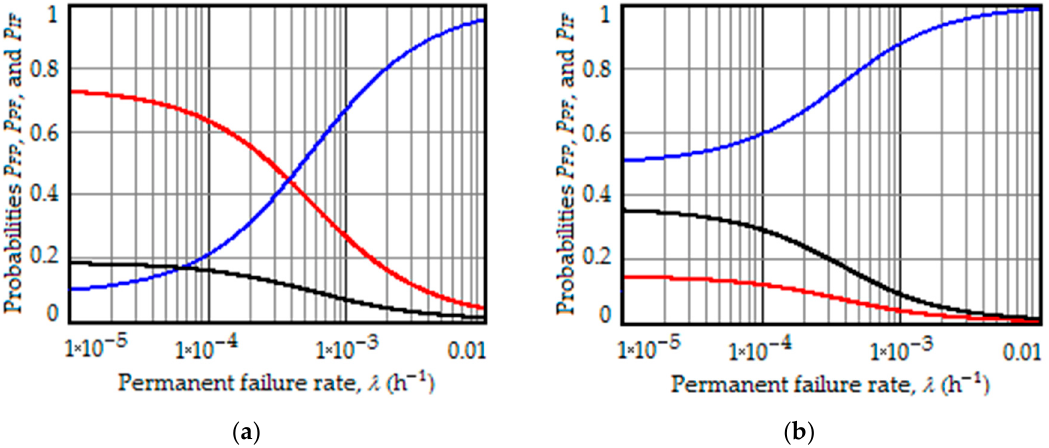
Figure 8. Dependences of the posterior probabilities of dismounting the LRU due to the in-flight false-positive (red curve), intermittent fault (black curve), and permanent failure (blue curve) on the permanent failure rate when θ = 10 − 4 h − 1 ; ( a ) 𝑃 (cid:3033)(cid:3039)(cid:3036)(cid:3034)(cid:3035)(cid:3047)(cid:3007)(cid:3017) = 1 × 10 (cid:2879)(cid:2871) ; ( b ) 𝑃 (cid:3033)(cid:3039)(cid:3036)(cid:3034)(cid:3035)(cid:3047)(cid:3007)(cid:3017) = 1 × 10 (cid:2879)(cid:2872) .